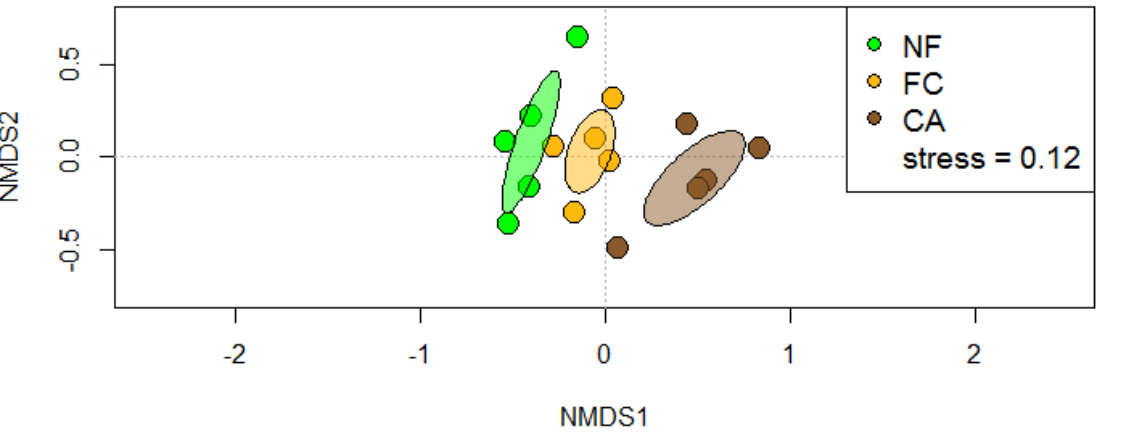
Figure 5. Non Metric Multidimensional Scaling (NMDS) Ordination diagrams of woody species (dbh ≥ 10 cm) across the natural forest (NF), coffee forest (FC) and coffee agroforest (CA). Table 3. Analysis of Similarity (ANOSIM) result comparing woody species composition in the natural forest, coffee forest and coffee agroforest. Comparison of Forest Types Global R = 0.3665, p < 0.001 R Statistics a P b natural forest vs. coffee forest − 0.024 0.56 natural forest vs. coffee agroforest coffee forest vs. coffee agroforest